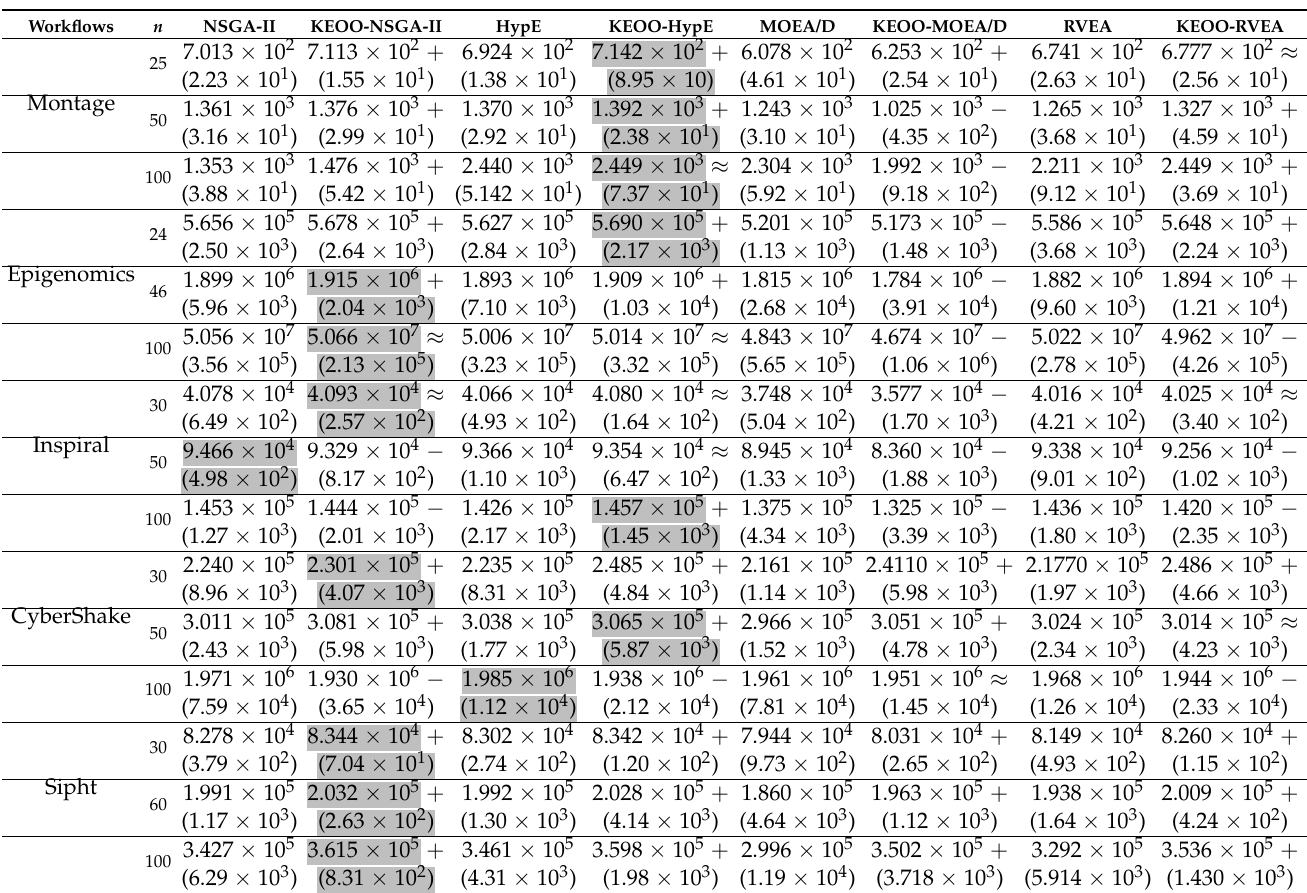
Table 5. Comparison results for the 8 algorithms on 15 workflows in terms of the hypervolume